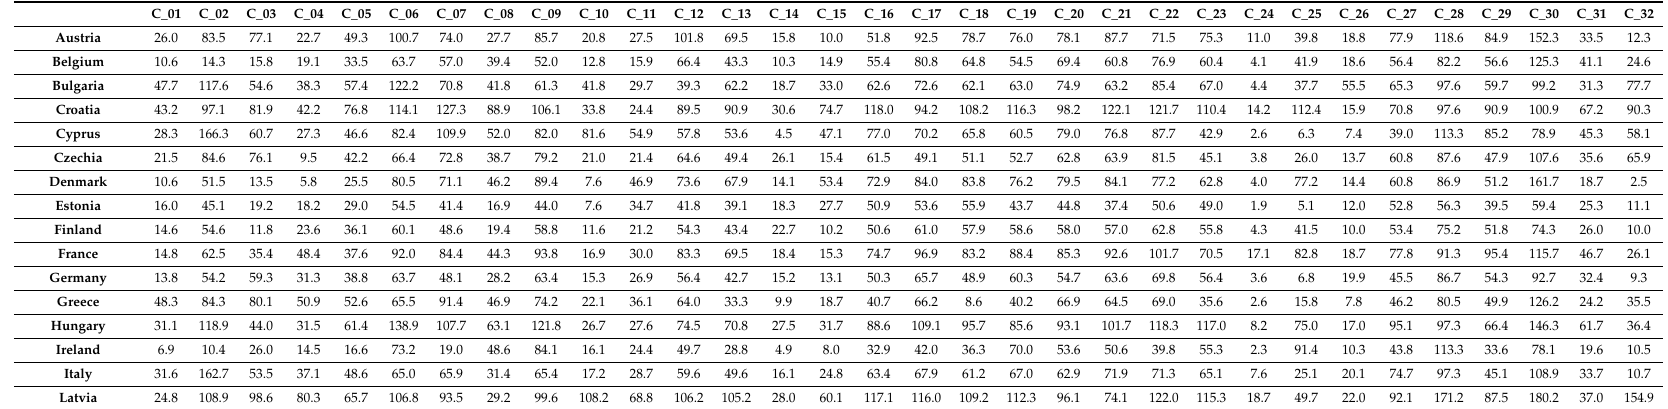
Table A6. Average employment (jobs) reduction caused by a reduction of 1000 tonnes of GHG emissions through a reduction in demand (disaggregated